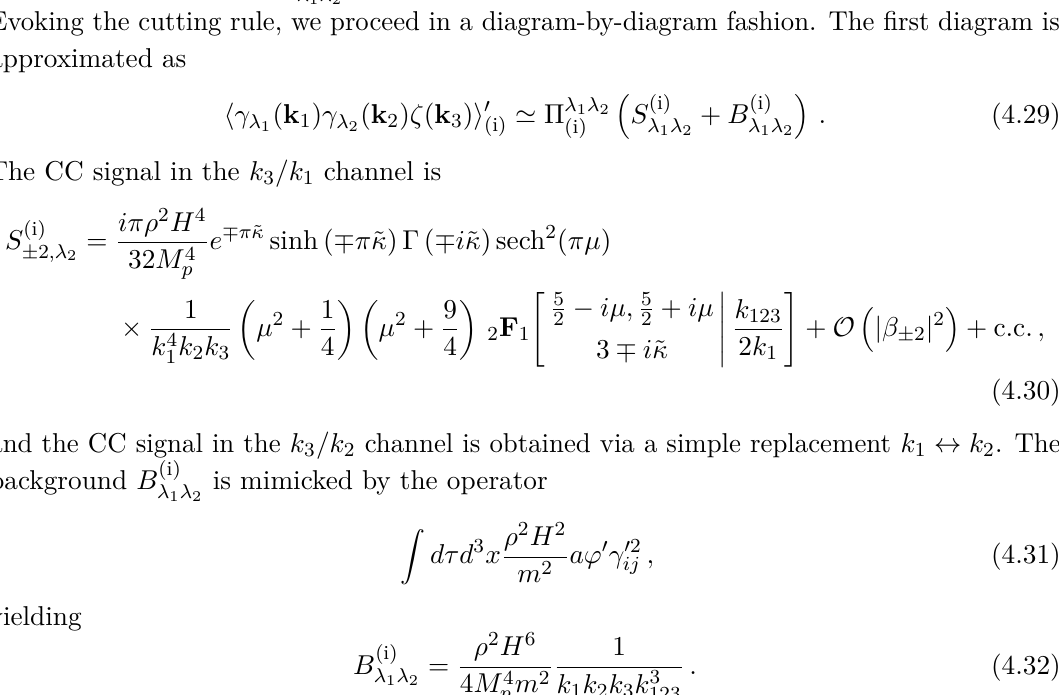
Figure 6 . Left: the two tree diagrams contributing to h γγζ i . Right: the kinematic configuration. The dynamical factors I ( i ) , ( ii ) are again given by (A.19) and (A.20) in the λ 1 λ 2